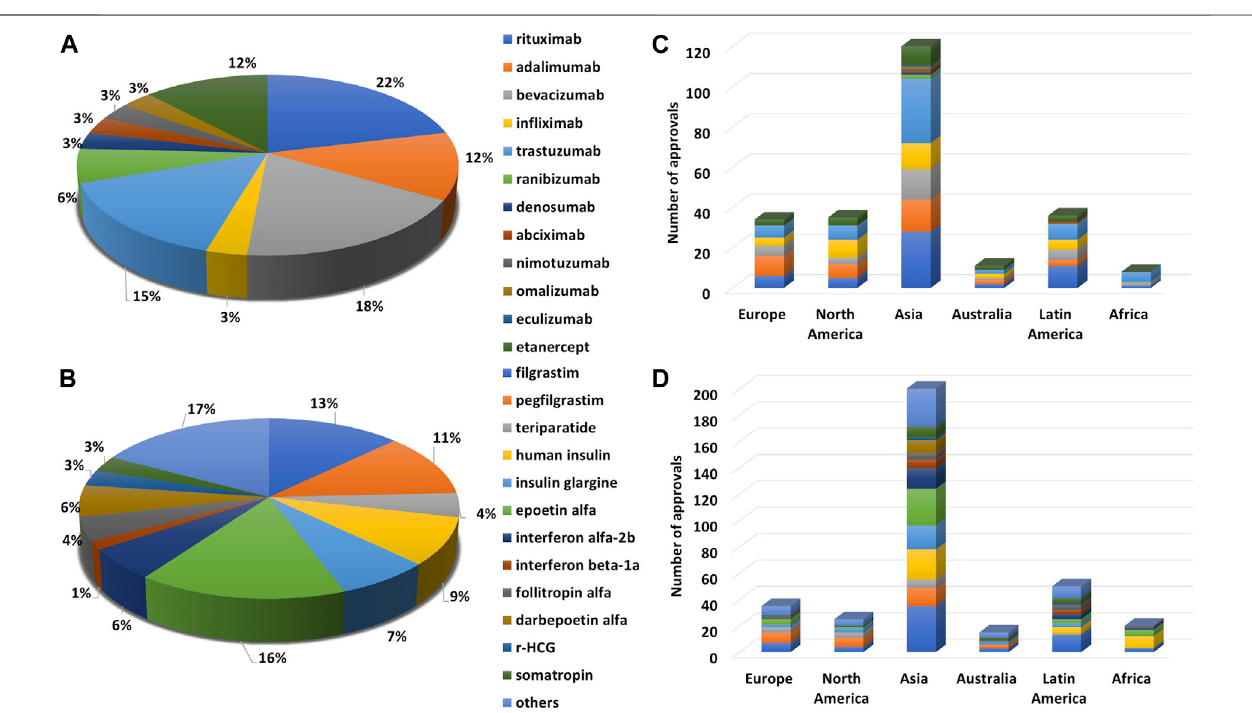
FIGURE 2 | Trend in biosimilar approval for different modalities depicted as percentage of total approvals for a given biologic under (A) mAbs and (B) non-mAbs and global biosimilar approvals (in numbers) across continents i.e., Europe, North America, Asia, Australia, Latin America, and Africa for (C) mAbs and (D) non-mAbs.